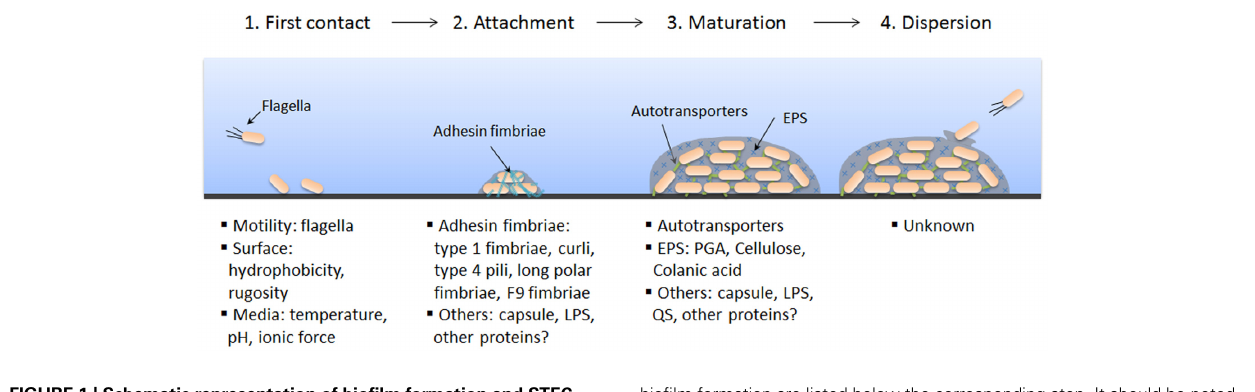
biofilm formation are listed below the corresponding step. It should be noted that biofilm formation in STEC is strain dependent and factors presented in this figure are not necessarily representative of all STEC biofilms. PGA, poly-N-acetyl glucosamine; EPS, extracellular polymeric substances; LPS, lipopolysaccharides; QS, quorum